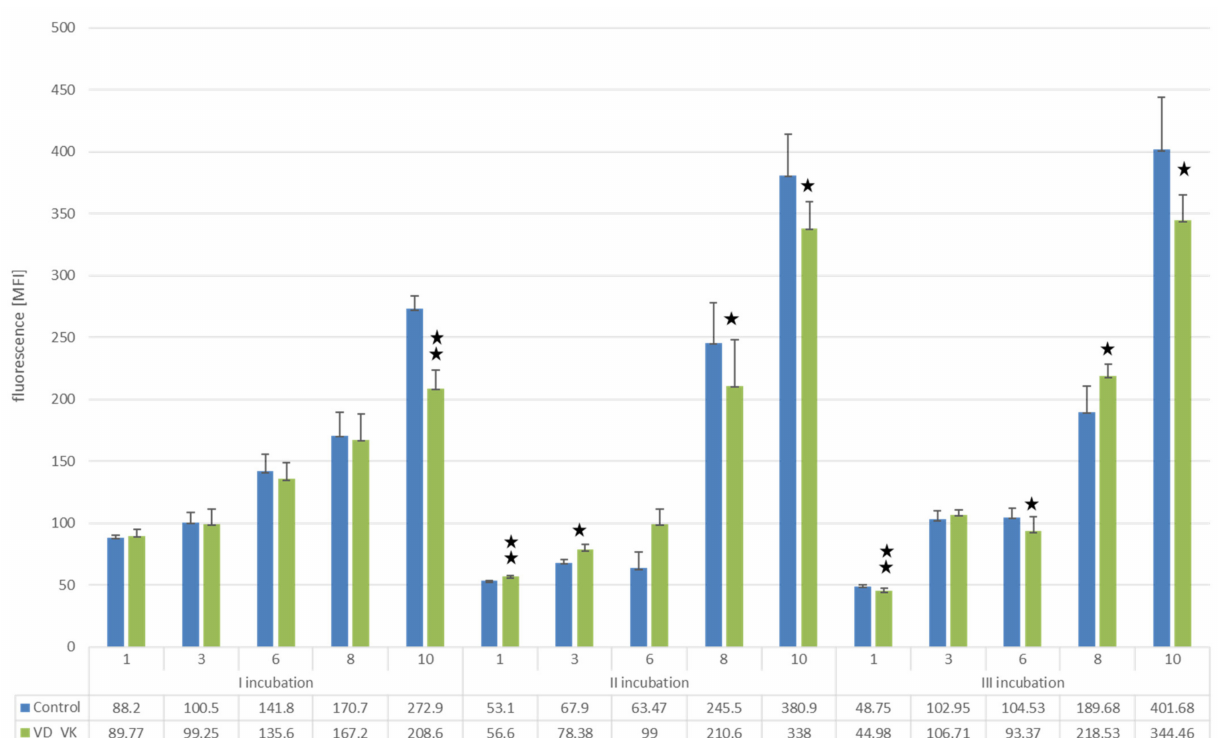
Figure 4. Analysis of U266 cell proliferation using the Alamar blue assay. The diagram shows the results after three times simultaneous incubation every 10 days with VD and VK or placebo (control). Measurements were performed on days 1, 3, 6, 8 and 10 after each incubation. Student’s t -test; ** p < 0.0001; * p <